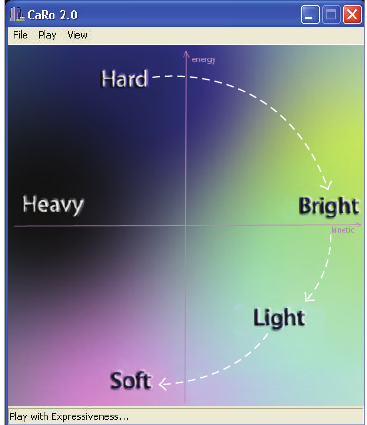
Figure 11: The graphical user interface of CaRo 2.0. The dotted line shows the trajectory drawn for rendering the hbls